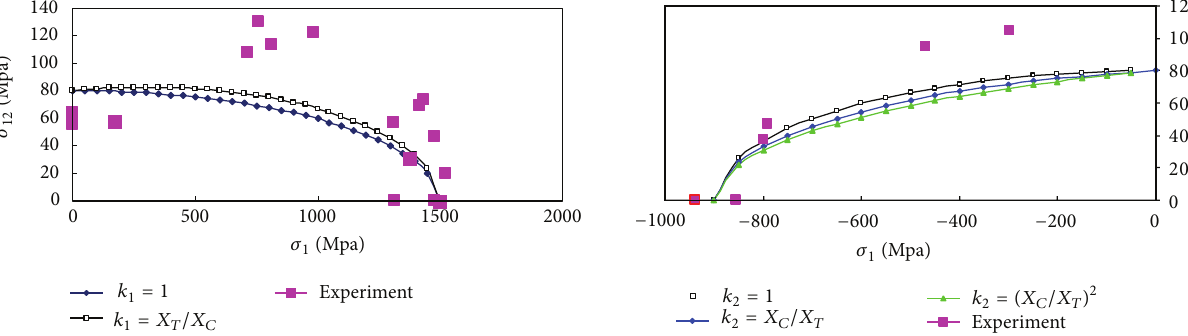
Figure 1: Fiber tensile failure envelope. Figure 2: Fiber compressive failure envelope.